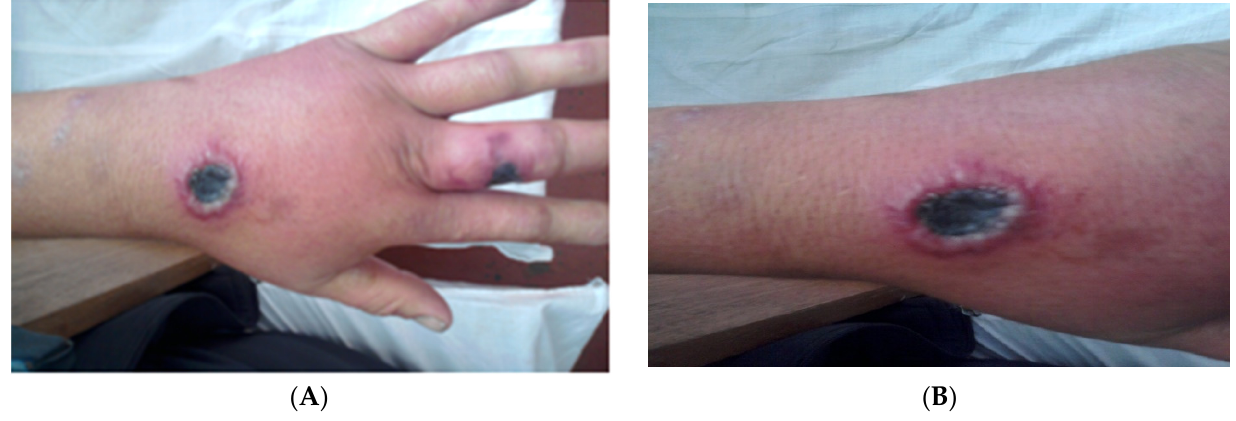
Figure 2. Typical lesions of cutaneous anthrax on the hand ( A ) and leg (anterior side) ( B ). The lesions are characterized by a central eschar with a ring of vesicles and surrounding edema that is characteristically painless. (Images supplied by Professor Ainura Kutmanova, and Dr. Saparbai Zholdoshev).